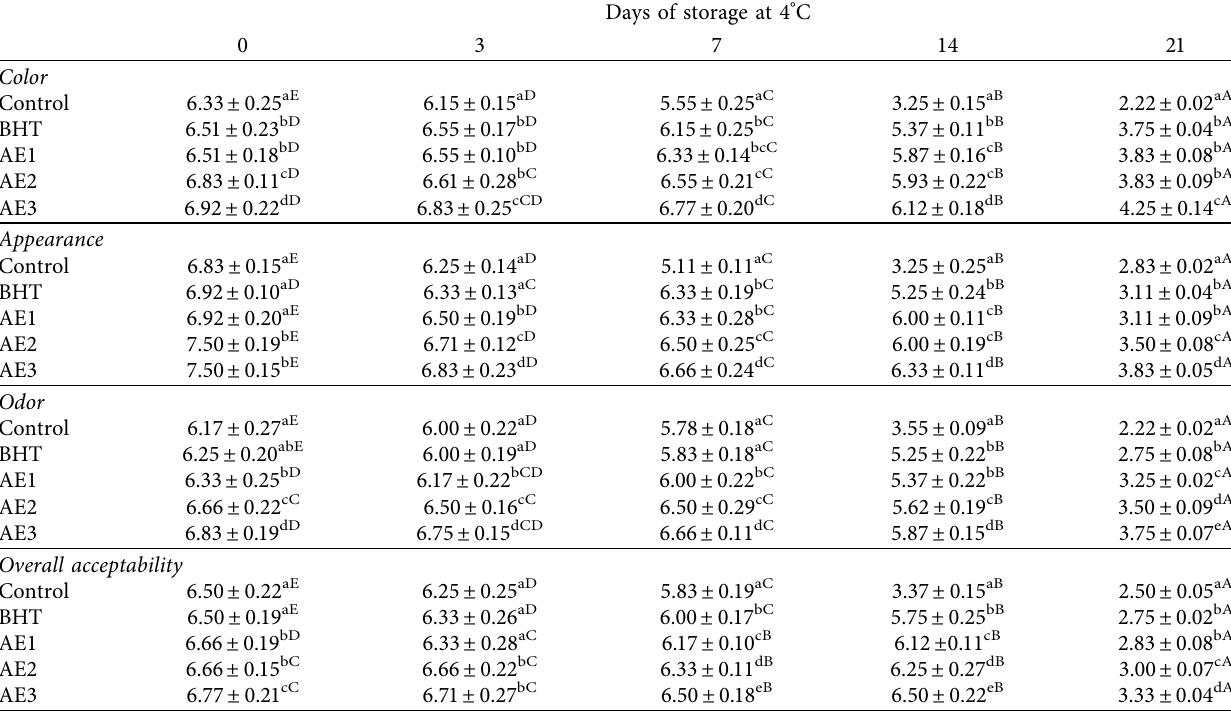
Table 4: Effect of the aqueous pomegranate peel extract on color, appearance, odor, and overall acceptability of raw minced meat beef stored at 4 °